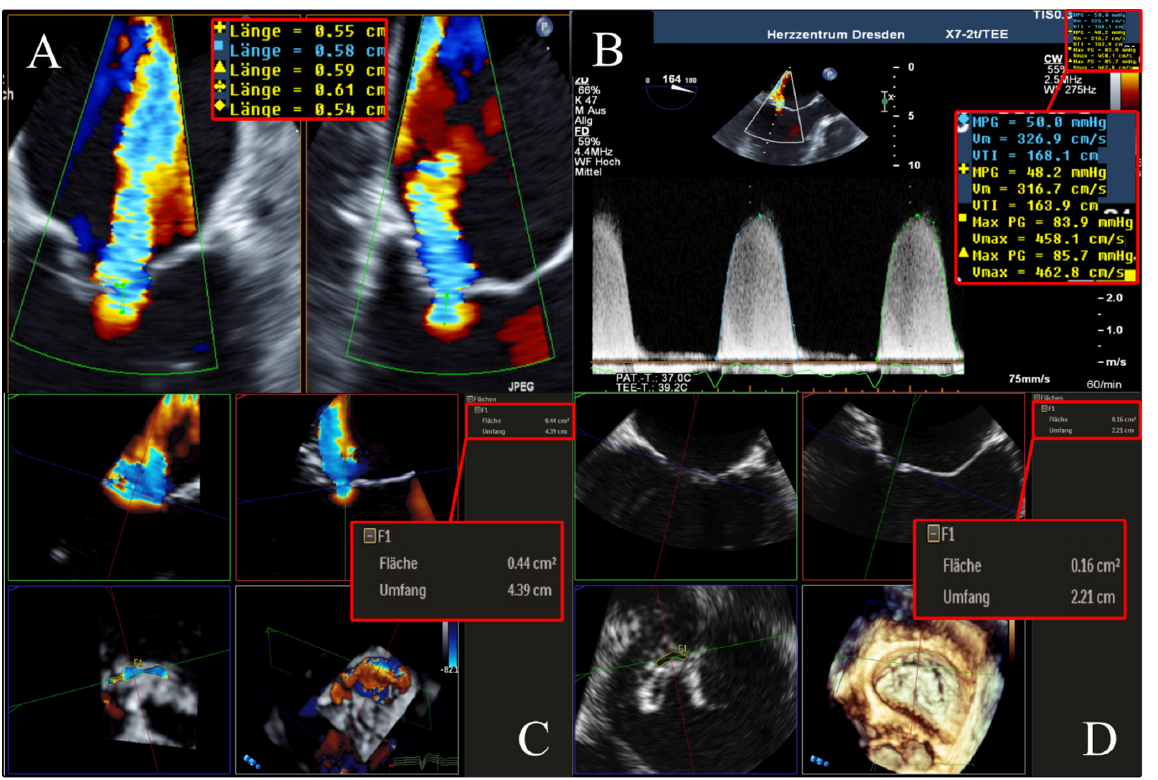
Figure 5. Example of a 51-year-old, male patient suffering from FMR due to non-ischemic dilated cardiomyopathy. ( A , B ) ERO quantified using 2D PISA method was 0.20 cm 2 , with a mean MR-Vmax of 460 cm/s. ( C ) 3D VCA derived by multiplanar reconstruction in a 3D color Doppler dataset was 0.44 cm 2 . ( D ) AROA derived by multiplanar reconstruction in a 3D Doppler dataset without color was 0.16 cm 2 . Abbreviations: FMR = functional mitral valve regurgitation; 2D = two-dimensional; PISA = proximal isovelocity surface area; CW = continuous wave; MR-Vmax = maximum mitral regurgitation velocity; 3D = three-dimensional; VCA = vena contracta area; AROA = anatomical regurgitation orifice